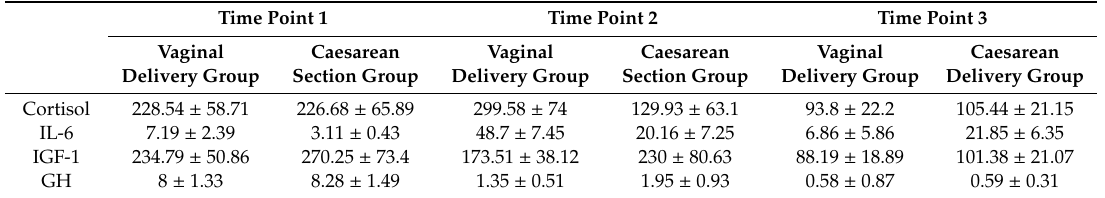
Table 2. Mean maternal serum hormonal levels reported on each of the three separate time-points (TP1: Prior to labor; TP2: 120 min following placenta delivery; TP3: 48 h following placenta delivery). Data are presented in the Mean ± SD